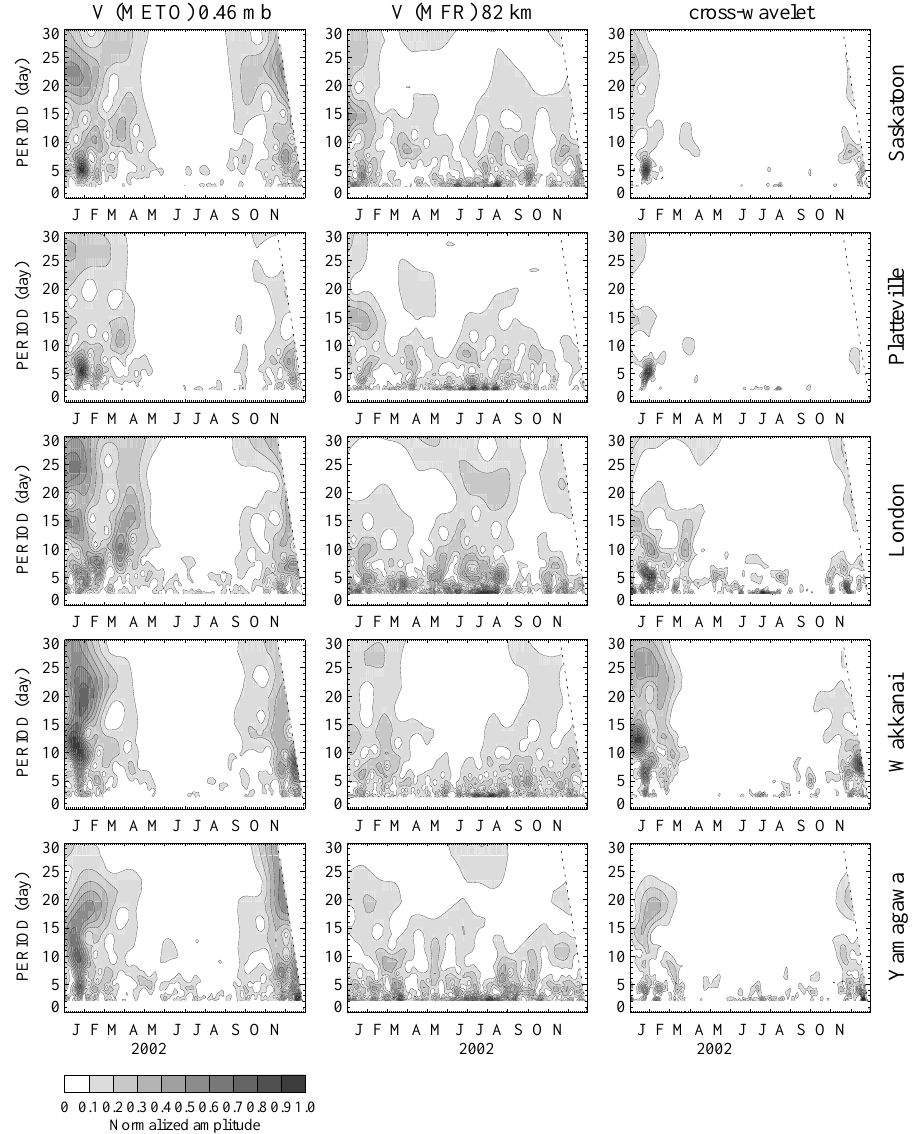
Fig. 7. ( a ) The same as Fig. 6a, but for the year 2002.